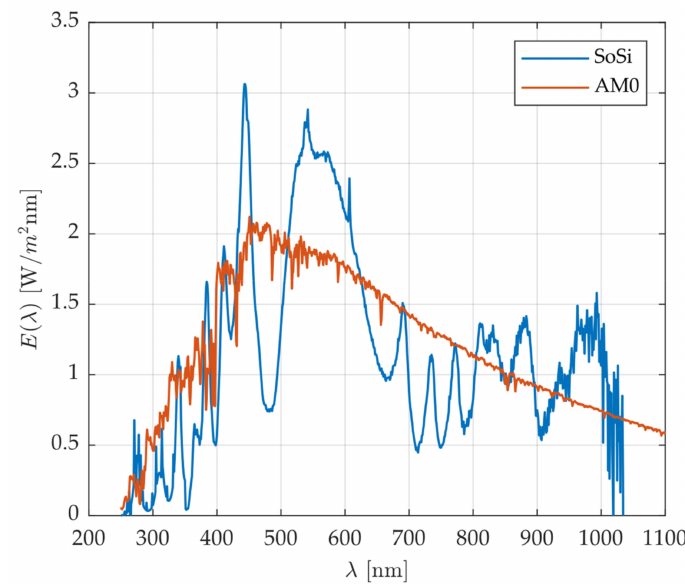
Figure 6. Spectral irradiance E( λ ) of the SoSi in comparison to Sun’s AM0 spectral irradiance.